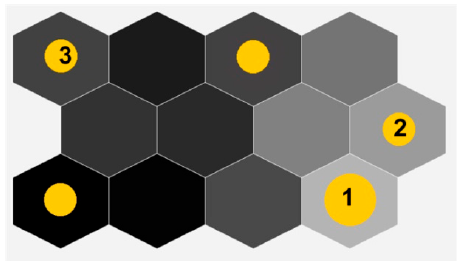
Figure 15. The Employees SOM of the IT department.